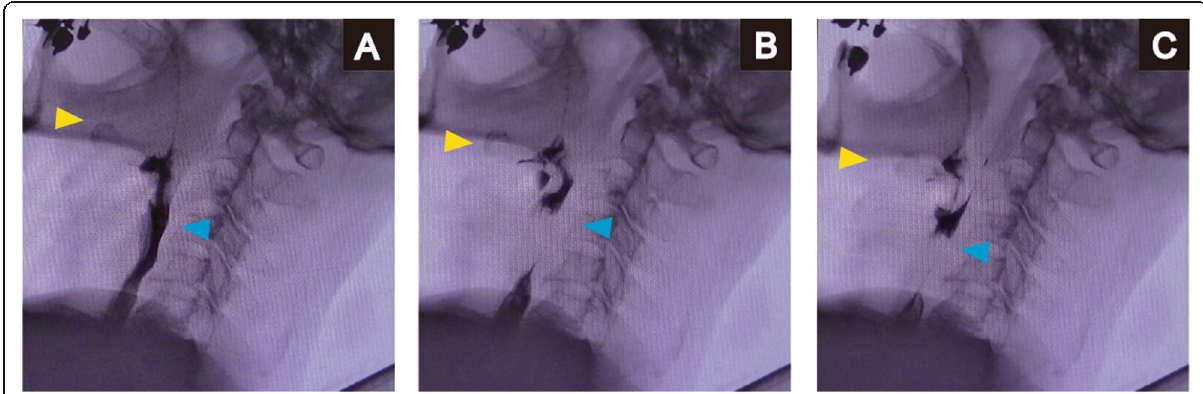
Fig. 5 Swallow functional test after cricopharyngeal myotomy. a The bolus easily entered the esophagus during laryngeal elevation in the pharyngeal phase. b Slight laryngeal penetration occurred in the esophageal phase. c Breathing was reinitiated with a small amount of pharyngeal residue. Yellow arrow; Hyoid bone, Blue arrow; Esophageal